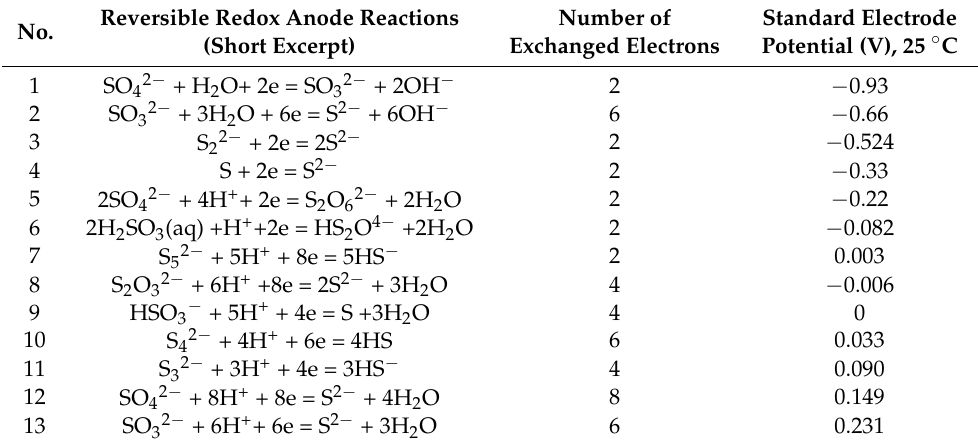
Table 1. Short excerpt of sulfide oxidation